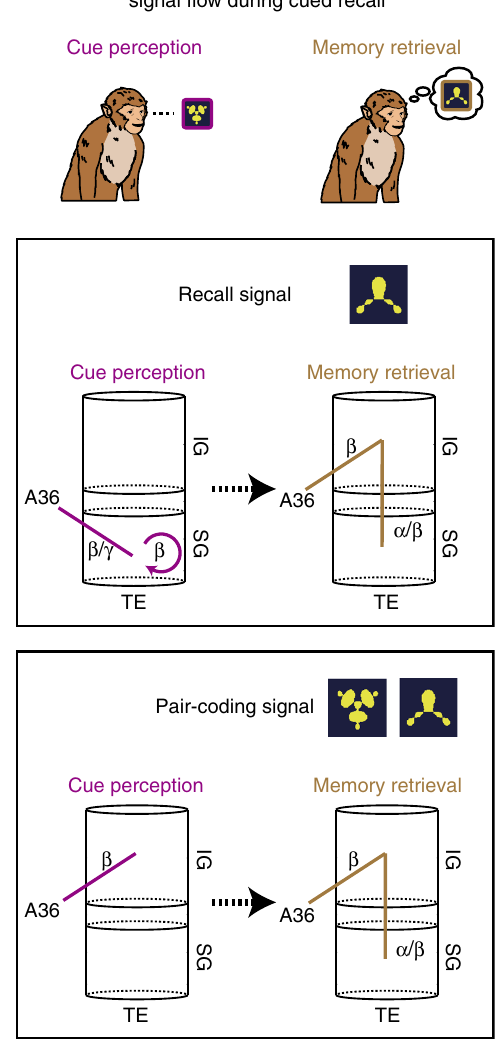
Fig. 5 Summary model for laminar transition of signal fl ow for